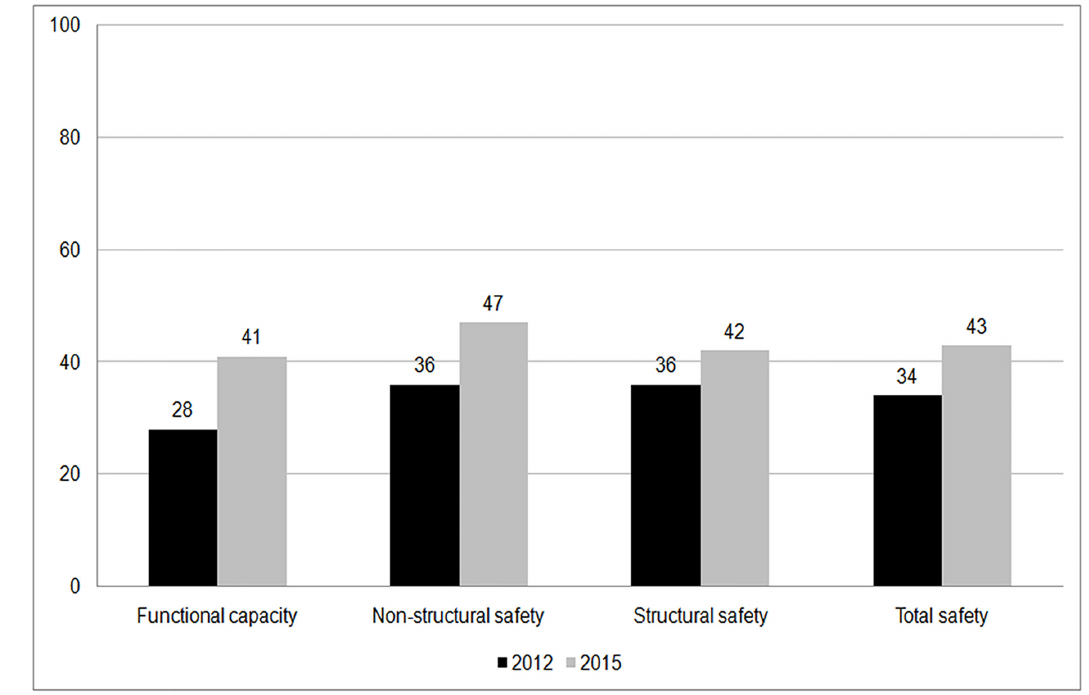
Fig 3. Trend of hospital disaster safety in I.R.Iran from 2012 to 2015, based on Farsi Hospital Safety Index.